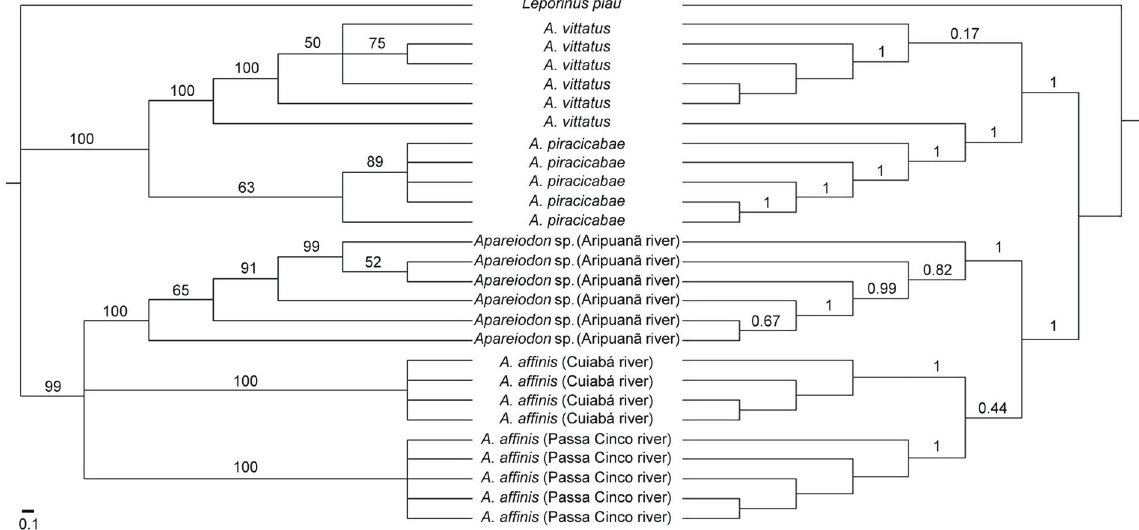
Figure 4 - Species tree showing phylogenetic relationships from the five analyzed species/populations of Parodontidae. To the left, topology for Maxi- mum Likelihood (numbers on the branches are bootstrap values). To the right, Bayesian tree (numbers on the branches are posterior probability). The scale bar indicates nucleotide substitutions per Table 1 - Estimates of evolutionary divergence over sequence pairs among groups.